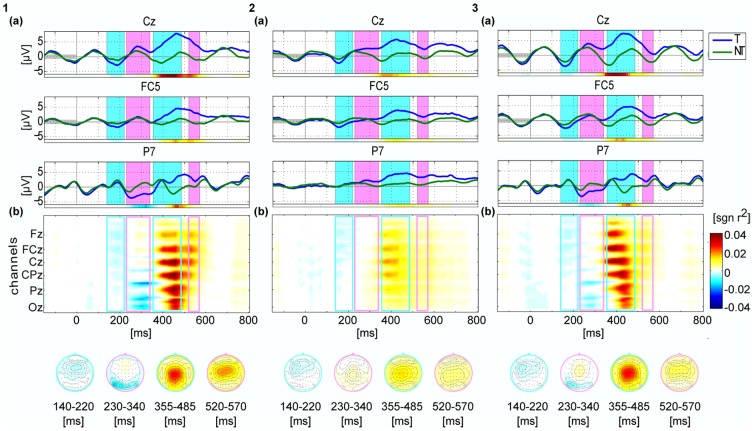
Grand averaged ERP and spatio-temporal diversity of the class-discriminative information for the first 3 conditions.Conditions are arranged in columns (left: V, middle: A, right: AV). All plots share the same color scale. The top row shows the ERPs for targets and non-targets of three selected electrodes Cz, FC5 and P7. The pink and green shade areas in each plot marked the time intervals, for which the scalp maps are shown at the bottom also colored accordingly. The colored bar underneath of each plot gives the signed correlation coefficient (sign r2). It indicated the difference between target and non-target classes for the chosen channel. In the middle, the spatio-temporal distribution of class-discriminative information was shown as a matrix plot, under which also the scalp maps of the chosen intervals were shown depicting the averaged r2 values within the time intervals. The matrix plot shows the signed r2 values for each EEG channel and for each time point. The light-blue and light-magenta rectangles depicted the chosen time interval as the shaded area in the top rows.